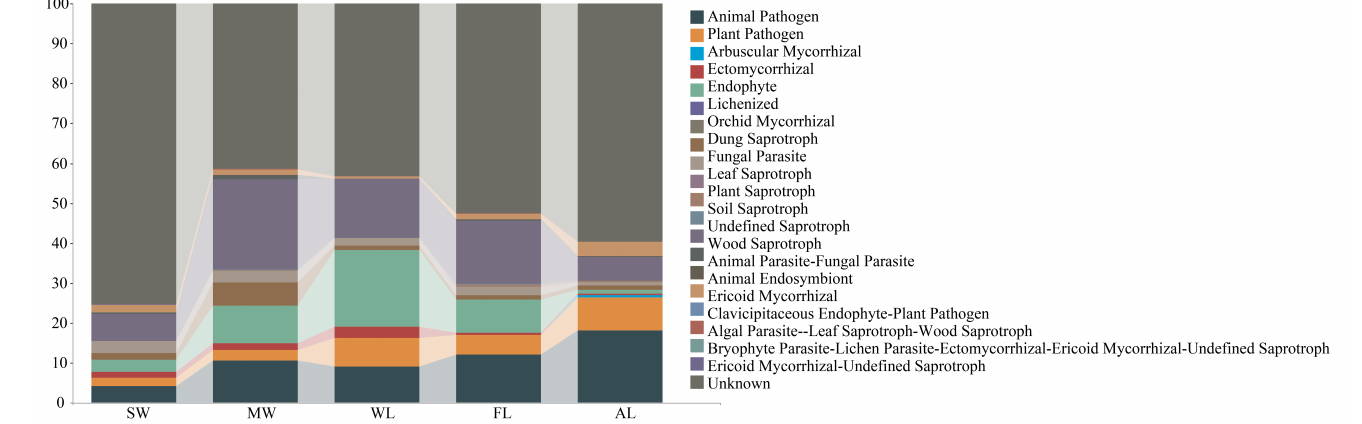
Figure 7. Variations in the composition of fungal functional groups inferred by FUNGuild. SW, swamp wetland; MW, meadow wetland; WL, woodland; FL, farmland; AL, alkaline